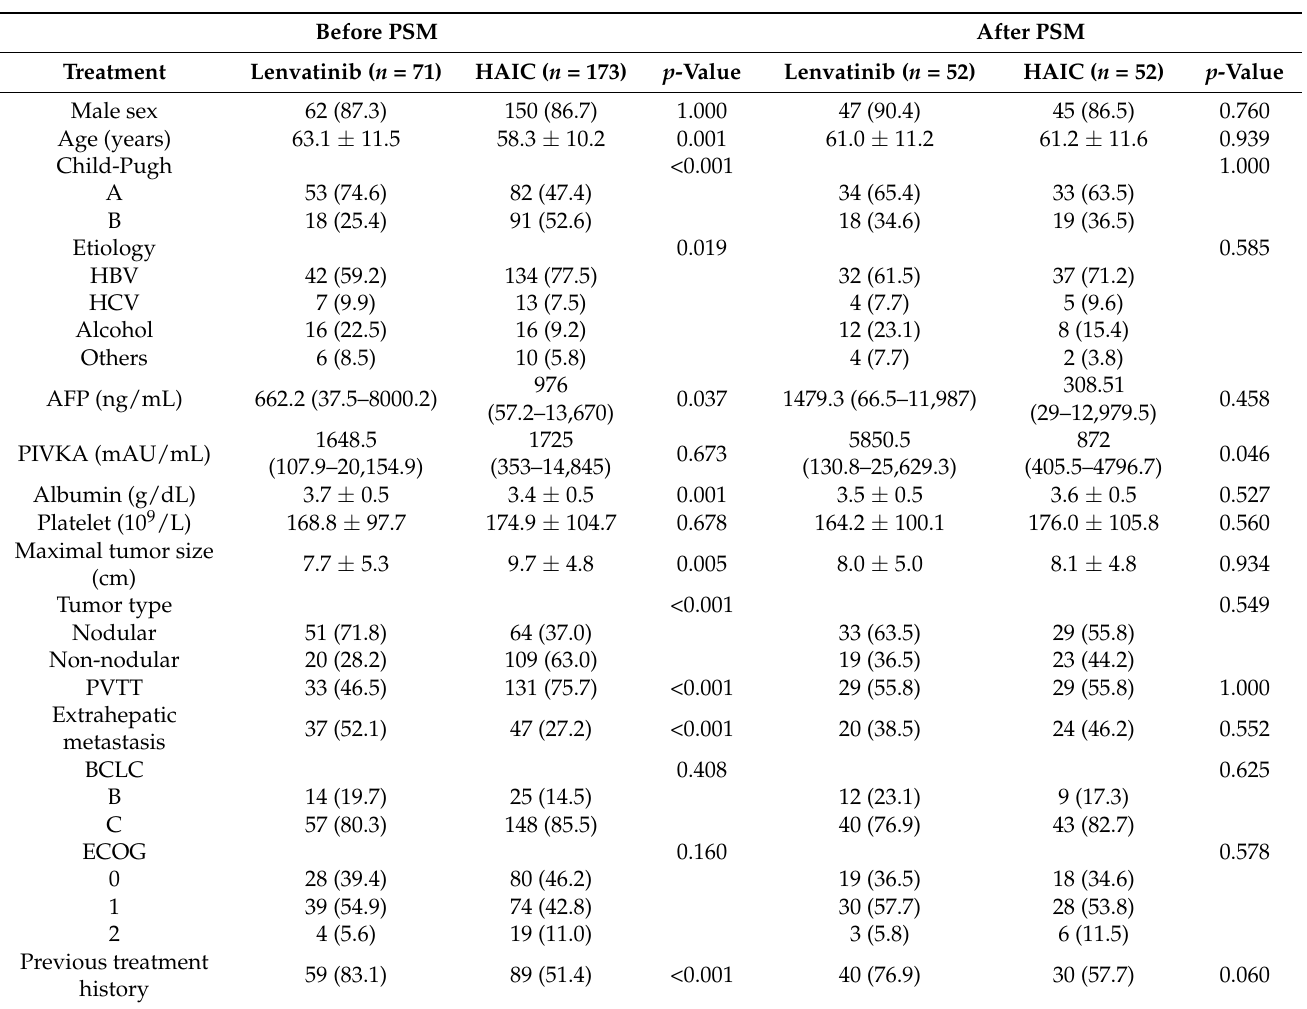
Table 1. Baseline characteristics of the study